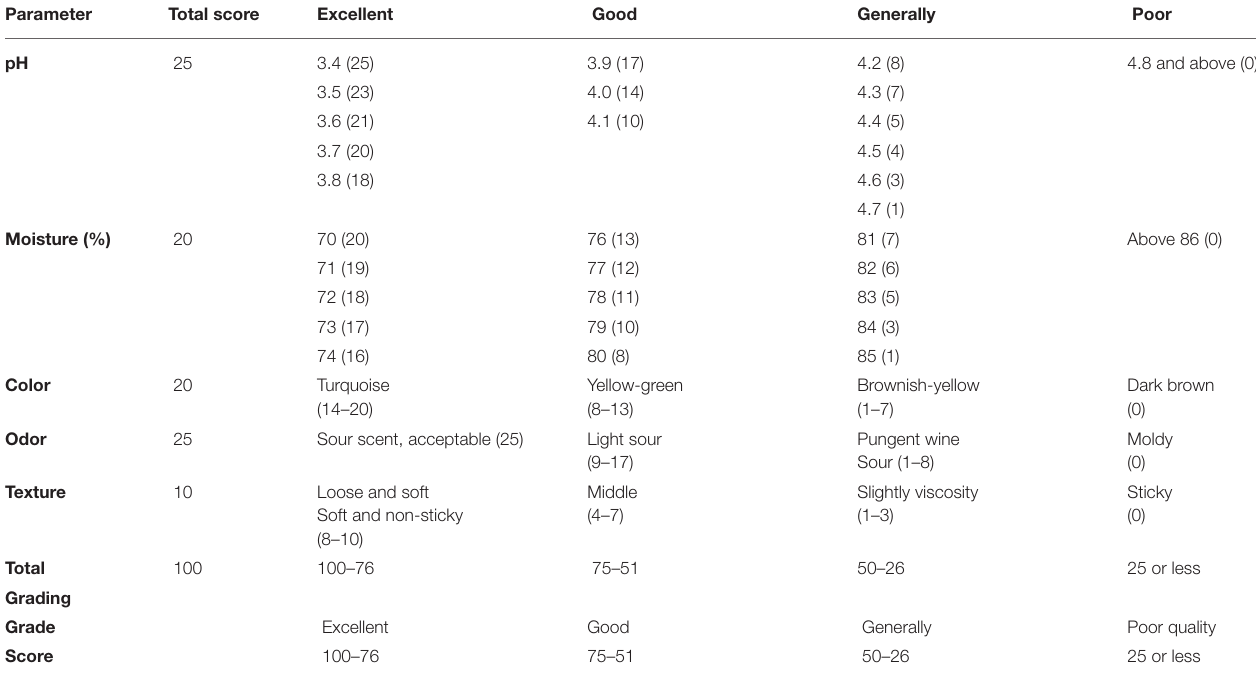
TABLE 2 | Silage quality evaluation standards.